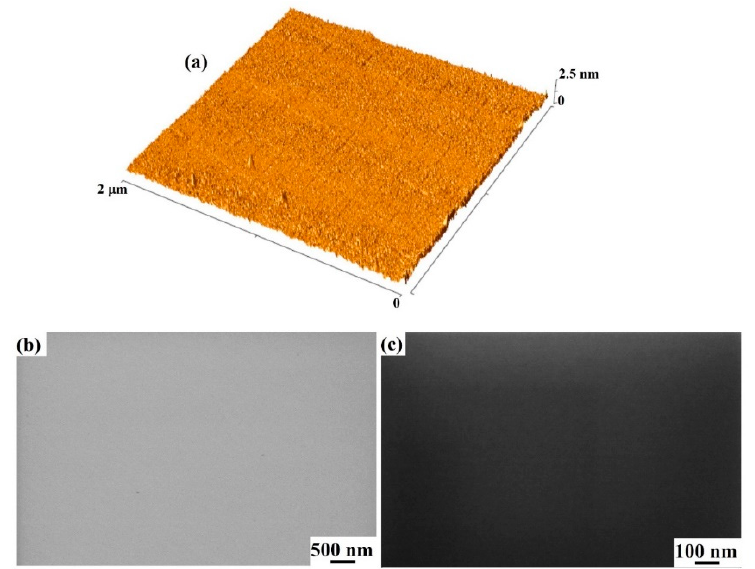
Figure 2. ( a ) A 2 μ × 2 μ m AFM image (three-dimensional reconstruction) of starting bare silicon carbide (SiC) surface. ( b , c ) SEM images of starting bare SiC surface with magnification increasing from ( b ) to ( c